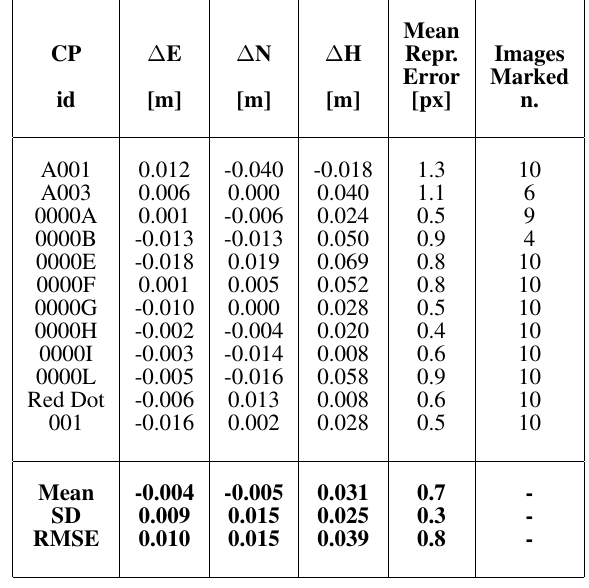
Table 5. Assessment with UAV track post-processing and direct georeferencing - 2021 block.